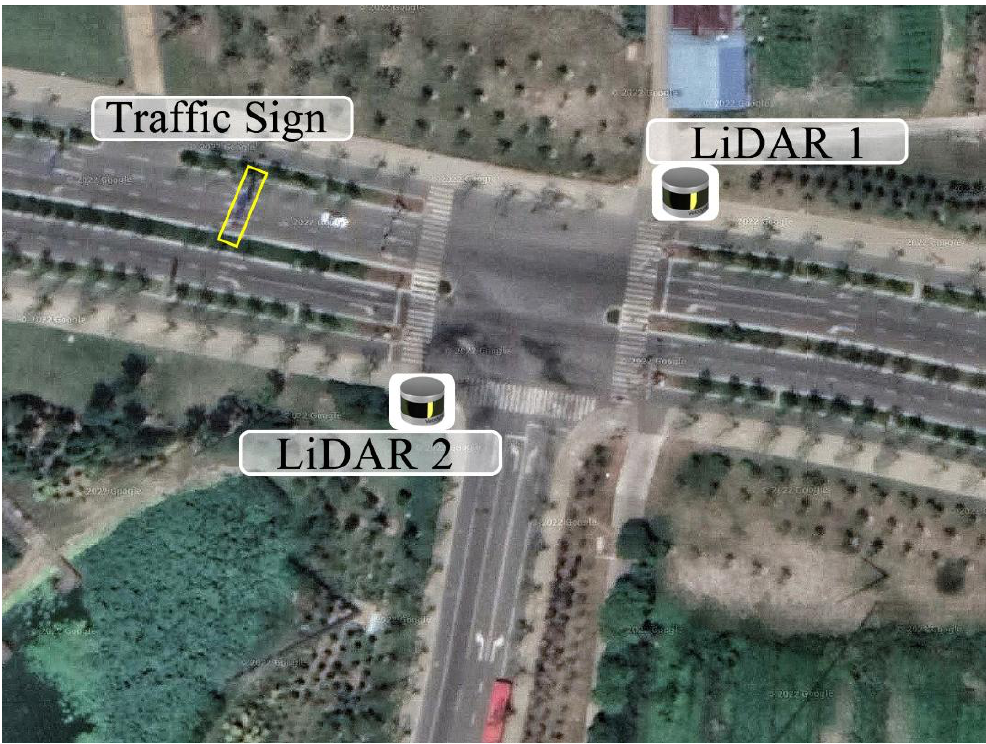
Figure 6. Intersection experiment